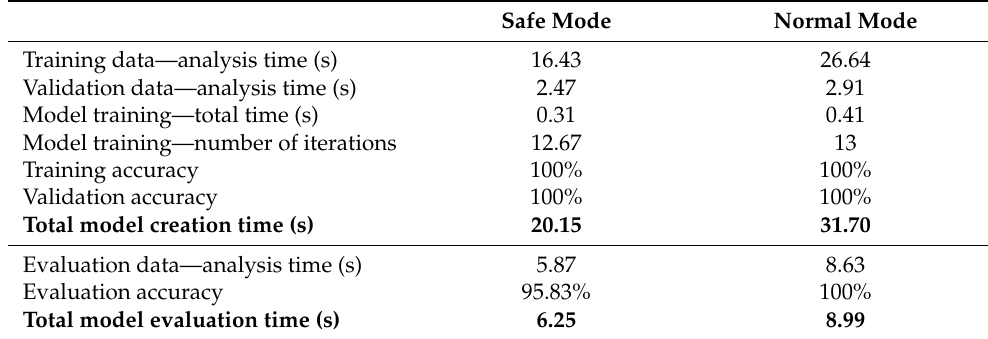
Table 1. Comparison of the averaged measurement results for the ‘ClassifierData’ dataset, executed using the safe and normal boot mode.